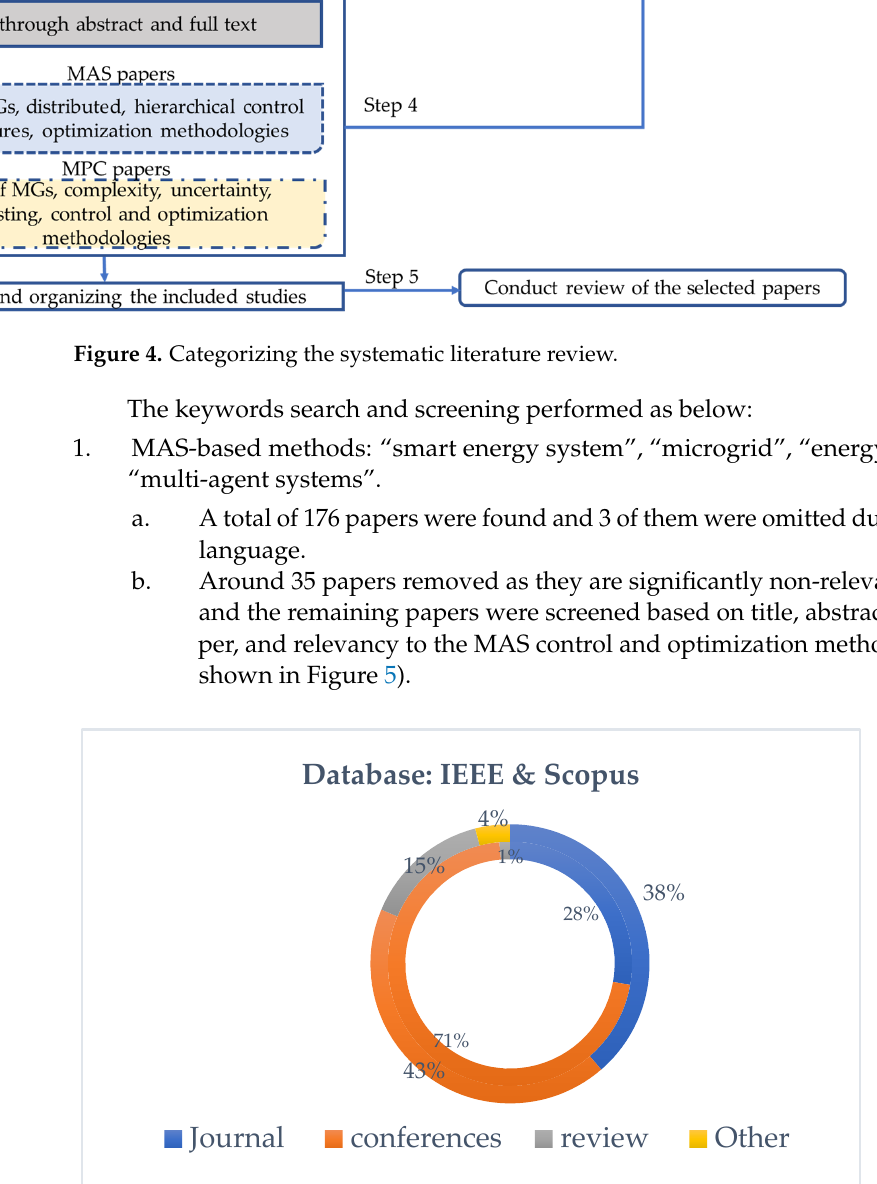
Figure 5. Papers identified in IEEE and Scopus database. The selected articles sorted to examine separately the MAS control methods in terms of stages, type of control (decentralized/distributed), the methodology employed, and complexity as specified below.